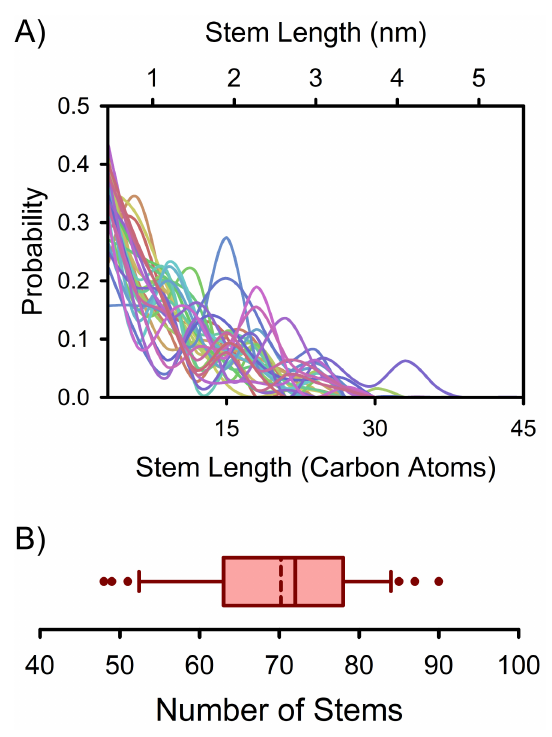
Figure 3. Stem distributions for clusters corresponding to 600 carbon atoms. ( A ) Overlaid stem length probability distributions. Each cluster is indicated with a different color. The stem length axis starts at 3 carbon atoms, the smallest possible stem based on the model and definitions used in this study. Each probability distribution has been represented using a spline curve to help guide the eyes; ( B ) A box-and-whisker plot of the number of stems composing the clusters represented in ( A ). The left and right bounds of the box indicate the 25th and 75th percentiles for the number of constituent stems. The central dashed and solid lines are the average and median numbers of constituent stems. The left and right error bars indicate the 10th and 90th percentiles. The dots indicate outliers not contained in the 10th to 90th percentile